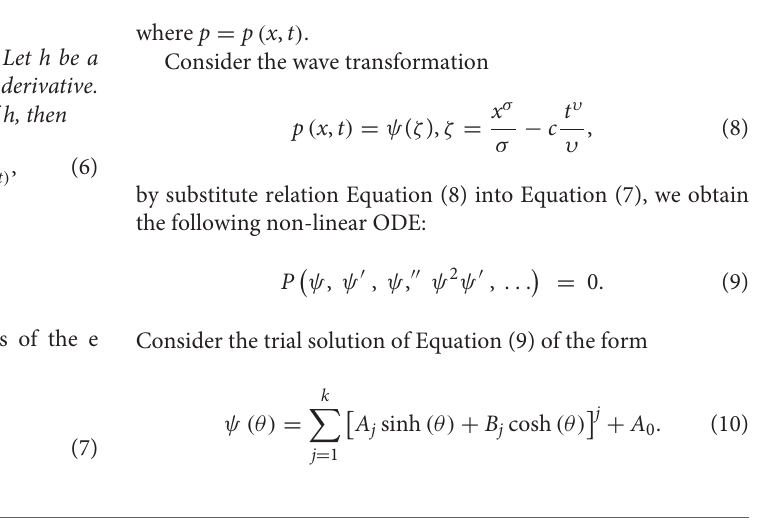
FIGURE 4 | 3D, 2D, and contour surfaces of Equation (32) where γ 5, c 1 7, α 0.7. = = =